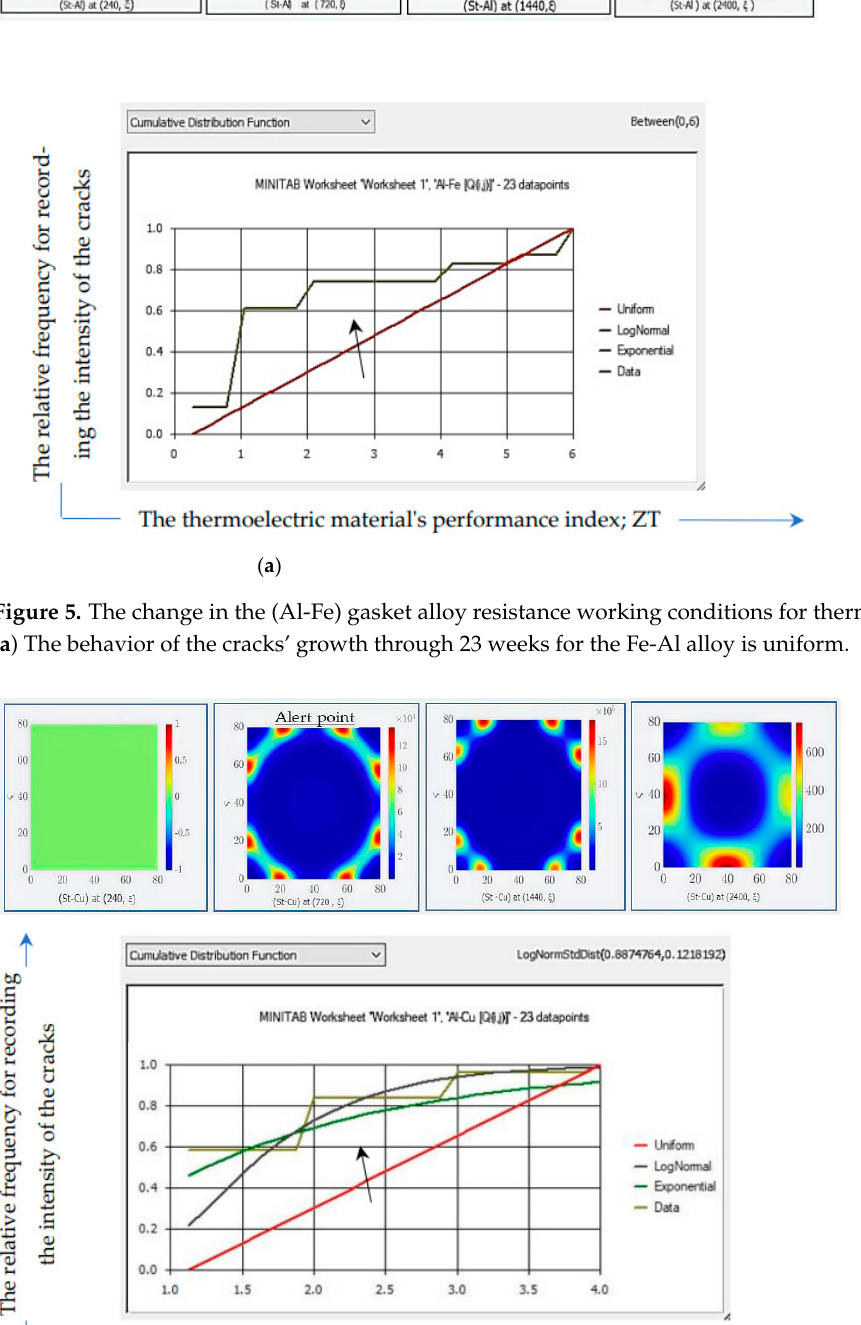
Figure 6. The change in the (Cu–Fe) gasket alloy resistance working condition for thermal transfer. ( a ) The behavior of the cracks’ growth through 23 weeks for Al–Cu alloy is Gaussian. The arrow points to both lognormal and exponential which have low error than uniform.